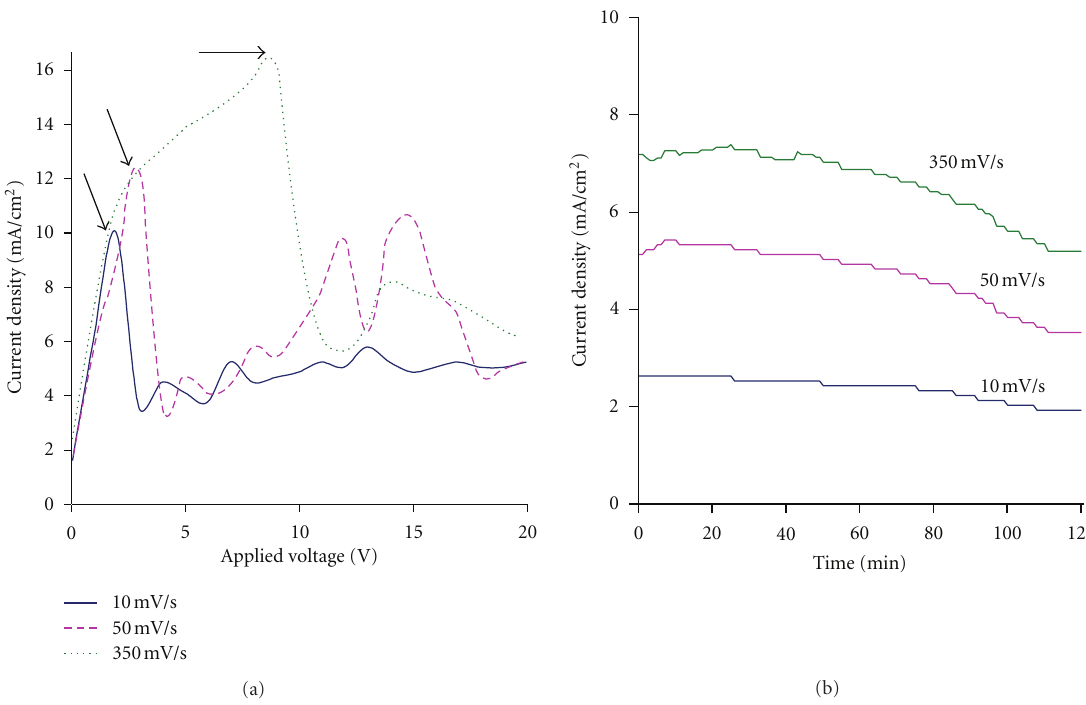
Figure 3: (a) Polarization curves at di ff erent voltage ramps prior to constant voltage at 20 V and (b) current transients at 20 V after the voltage ramp has